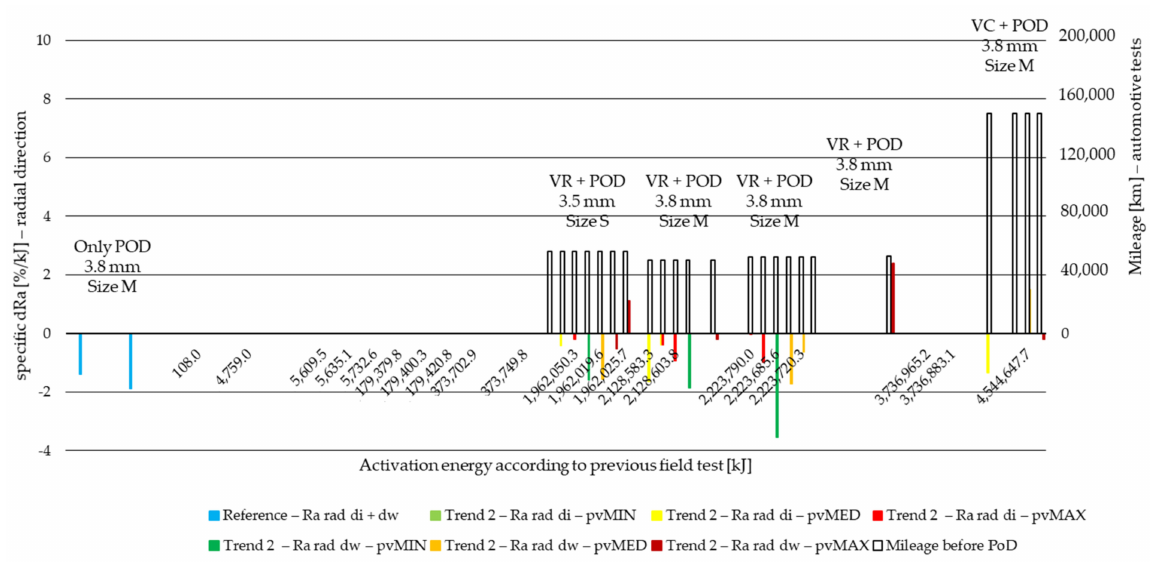
Figure 15. Radial direction PoD specific Ra difference values of cut material samples from inner and working diameter after minimum, medium and maximum pv level pin-on-disc tests with previous field-test (Table 2) mileage along Joule scale—Trend 2: moderate load cases: VR,